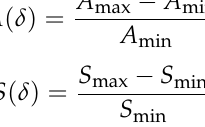
Table 3. Comparison of peak acceleration of the two reactors.